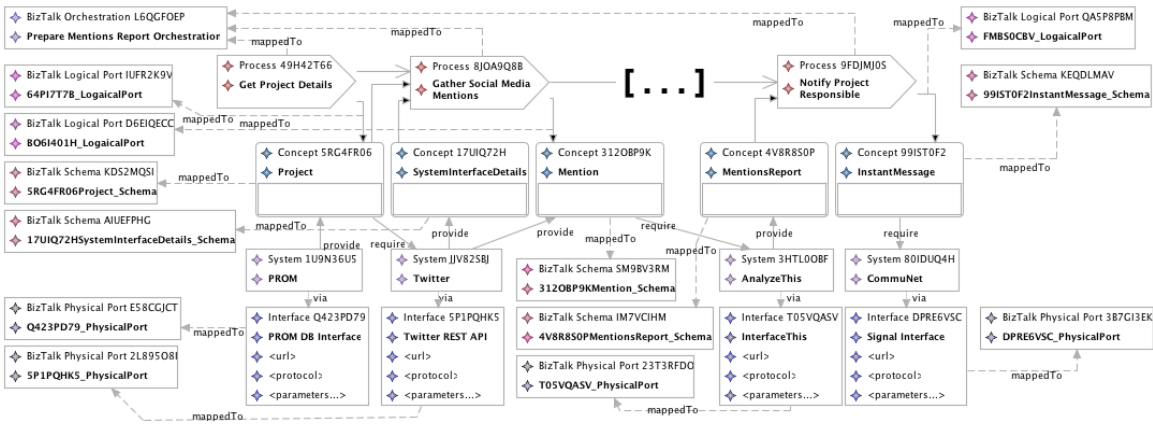
Figure 10. Mapping model of the integration solution for the case of